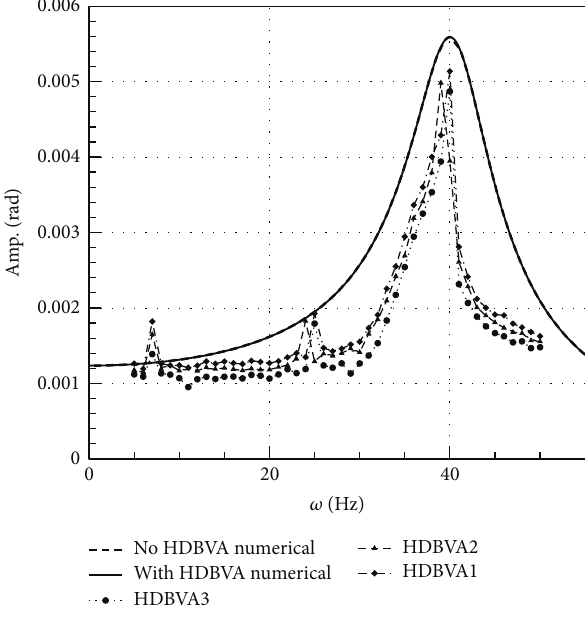
Figure 24: Frequency response of 𝜃 𝑋 DOF of case Figure 10(a), HDBVAs start at the far-from-force